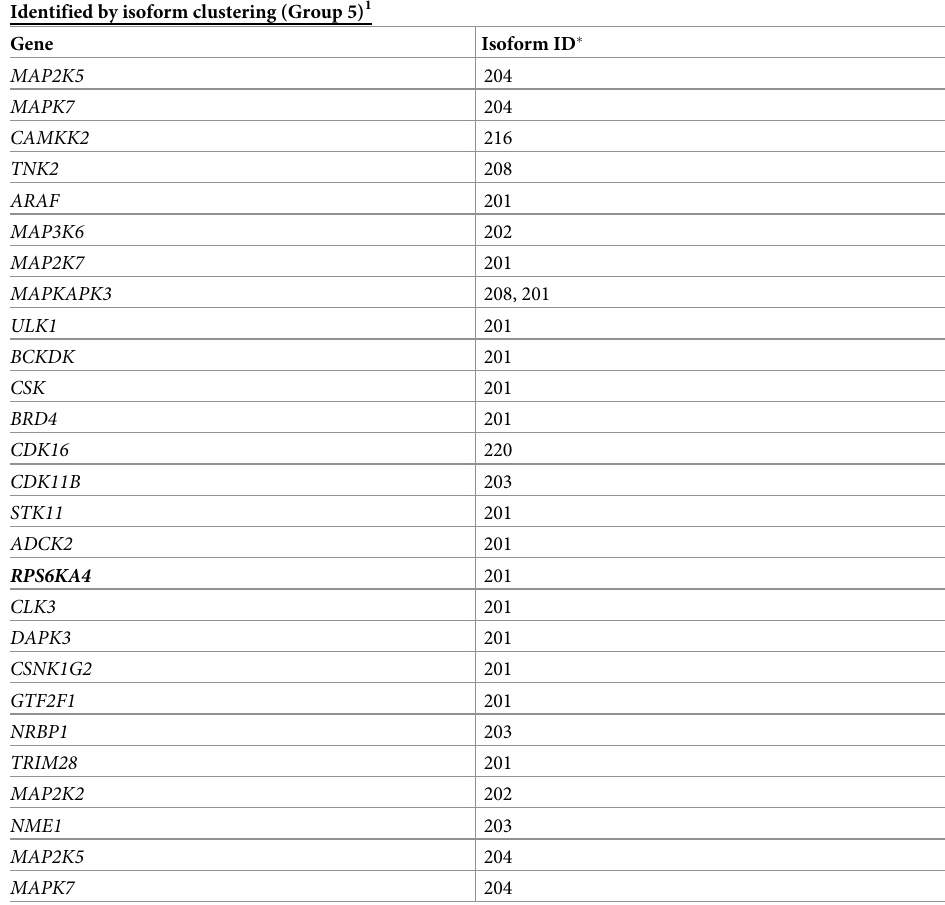
Table 6. Kinase genes with correlated decreased expression in metastatic samples.